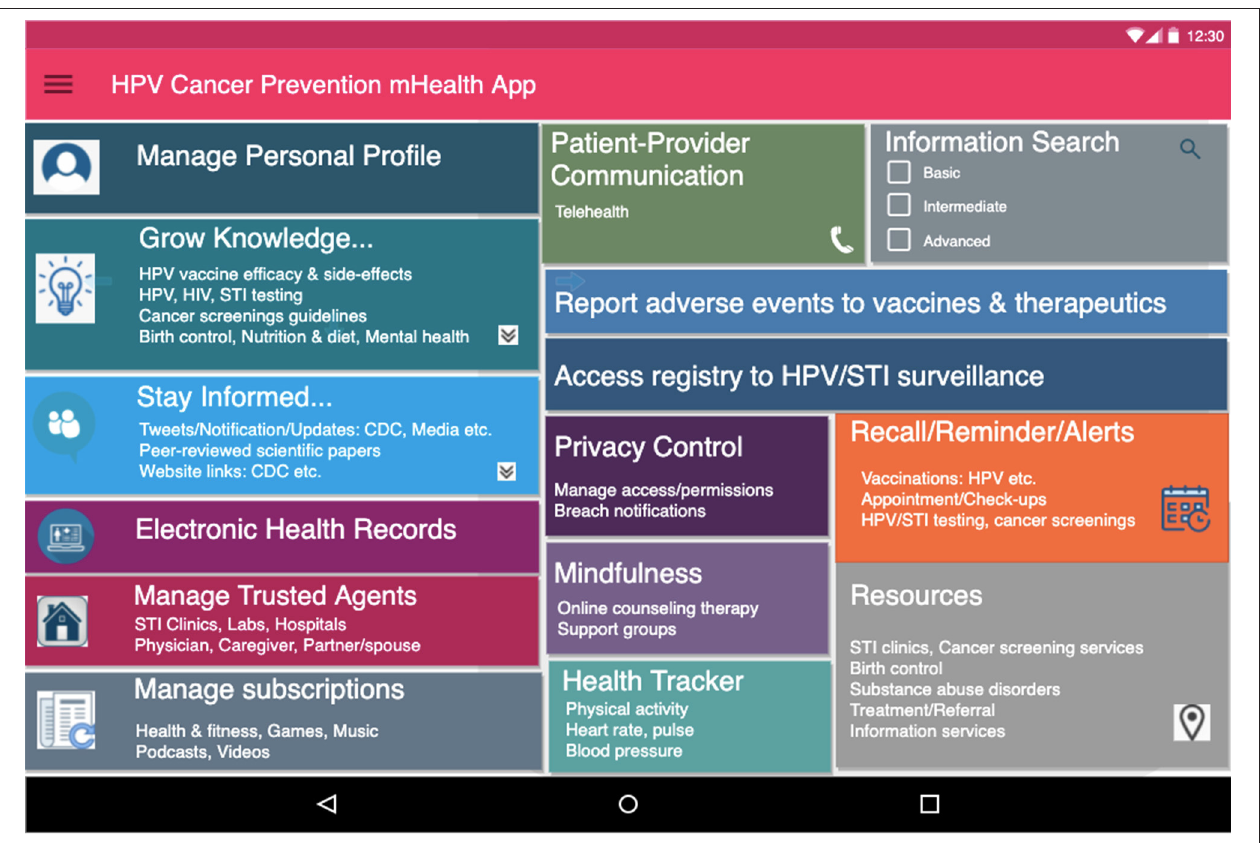
FIGURE 2 | Proposed dashboard interface for PHL-based application. Initial user-friendly interface for PHL-based app. The app supports the following: (a) Social features (b) utilizes SDoH data e.g. access to nearby resources (c) facilitates knowledge acquisition and recommendations on safe sex behavior (e) manages trusted agents (including partners, physicians, family members) and